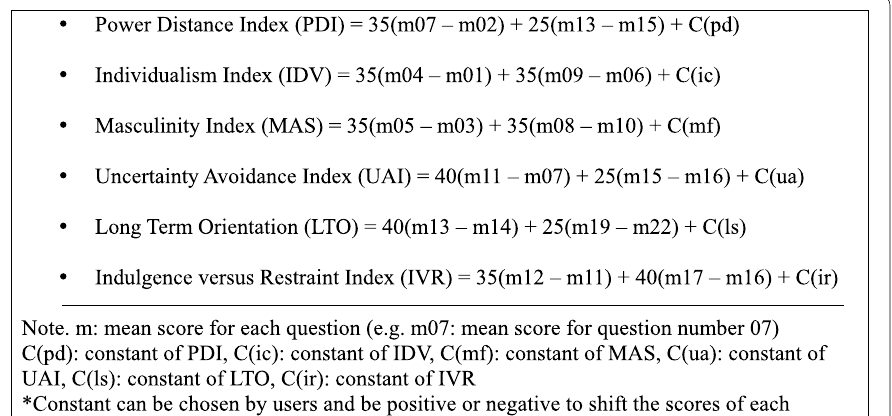
Fig. 1 Formulas for index calculation of Value Survey Module (VSM)